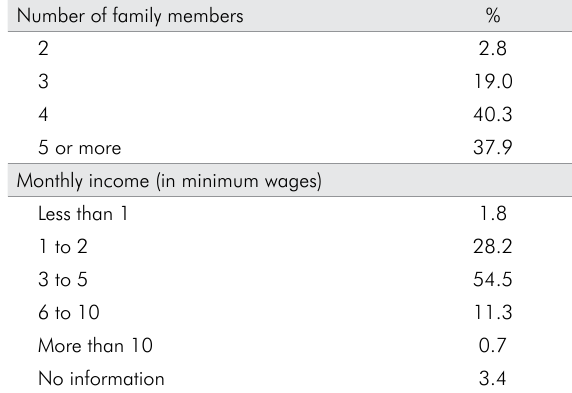
Table 6. Social and economic characteristics of the studied children’s family, according to the number of family members and total monthly income. Birigui, SP, Brazil,